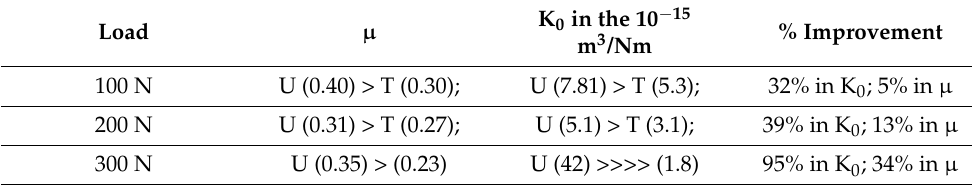
Table 4. Comparative performance of composites under varying